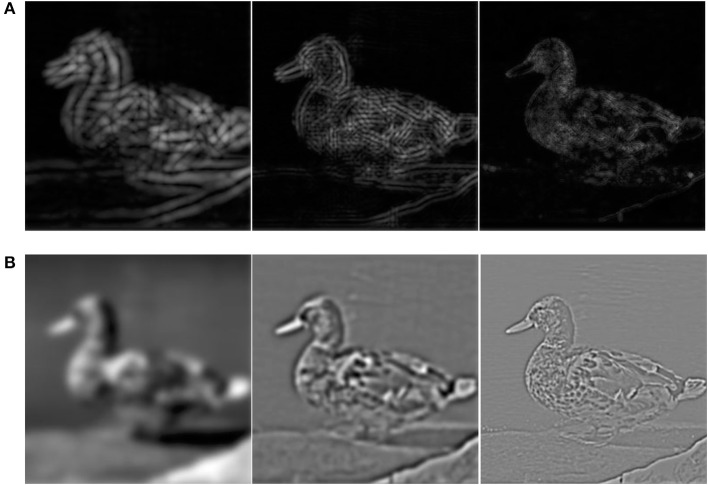
A sample image filtered into different spatial frequency bands using Gabor filters and Gaussian bandpass filters. Image filtered into the LSF, ISF, and HSF bands are respectively shown from left to right. (A) Image of each frequency band is the accumulation of the outputs of Gabor filters in four orientations (0, 45, 90, and 135°). (B) Gaussian bandpass filtered images using HLP1, HBP, and HHP2 filters (see Section 1).